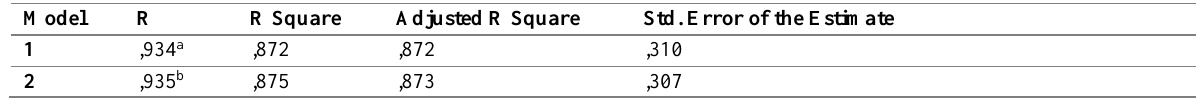
Table 7: Coefficient of Determination